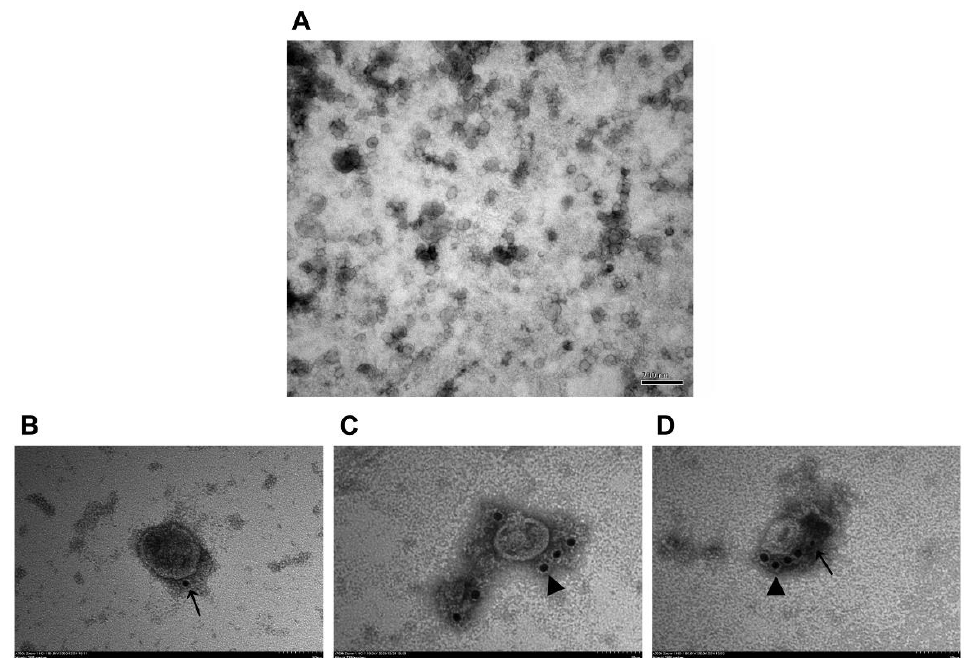
Figure 4. Purification TEM and immune-electron microscopy (IEM) of BVDV-VLPs. ( A ) Sucrose- purified VLPs were examined by TEM. All observed VLPs were spherical in morphology and were about 50 nm in diameter. Images were obtained with a JEM-1200EX (JEOL, Tokyo, Japan) transmission electron microscope at 80 kV; scale bar represents 200 nm. ( B ) BVDV-VLPs labeled for E2 with E2 mAb 348 and 5 nm colloidal gold-conjugated goat anti-mouse antibody. ( C ) BVDV-VLPs labeled for E rns with E rns pAb and 10 nm colloidal gold-conjugated goat anti-rabbit antibody. ( D ) BVDV-VLPs double-labeled for E2 (5 nm gold labels) and E rns (10 nm gold labels). Black arrows point to E2, black arrowheads point to E rns . Images were obtained with a HT7800 (Hitachi, Tokyo, Japan) transmission electron microscope at 80 kV; scale bar represents 50 nm.